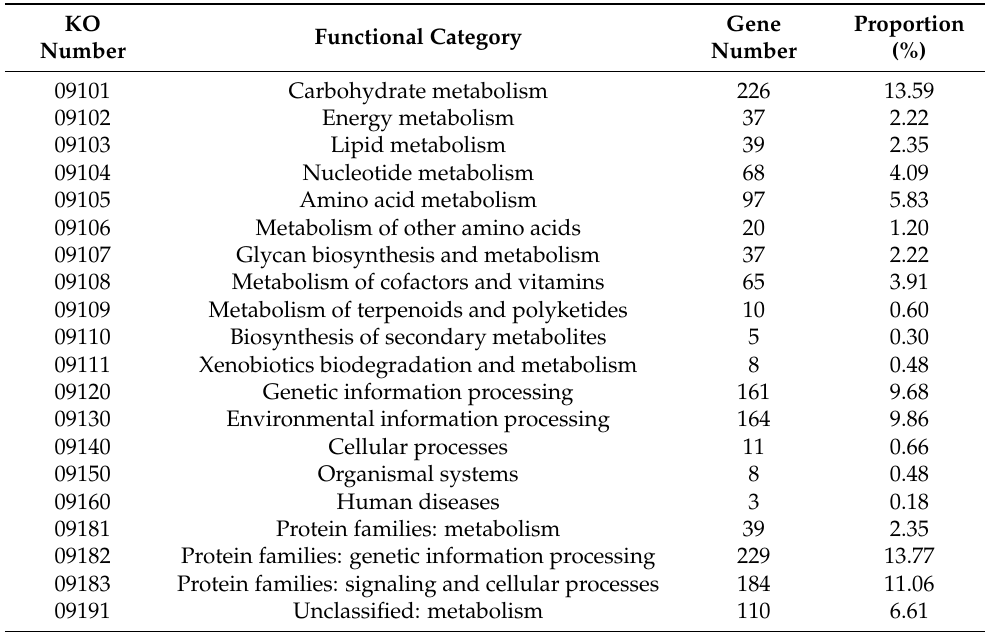
Table 3. KEGG orthology (KO) categories of identified protein ‐ coding genes in the Lactiplantibacillus plantarum DJF10 genome.